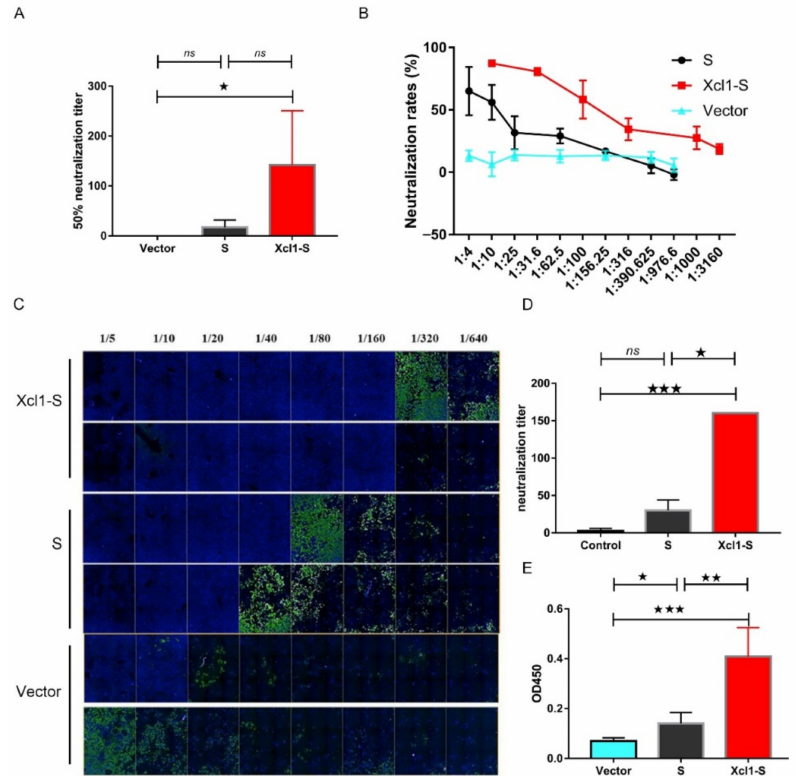
Figure 4. SARS-CoV-2 wild-type and pseudovirus neutralization assay. ( A ) The 50% neutralization titer of serum samples obtained from Xcl1-S-, S- or pVAX1-immunized mice were analyzed using VSV- based pseudovirus displaying spike, which carried an mCherry gene. ( B ) The mCherry fluorescence inhibition rates for different serum dilution ratios were displayed. Curve fitting was used to determine the half-maximal inhibitory concentrations (NT50), which were presented as the neutralization titers in ( A ). ( C ) Fold change in serum neutralization titers against wild-type viruses. ( D ) A statistical analysis was performed for ( C ) using a two-tailed paired t test. ( E ) Detection of SARS-CoV-2 S protein-reactive antibodies in alveolar lavage fluid. C57BL/6 mice ( n = 5 per group) were immunized on days 0 and 14 with Xcl1-S, S or pVAX1. Alveolar lavage fluid was collected with a 1:100 dilution on day 28 and assayed for SARS-CoV-2 spike protein-specific IgG antibodies using an ELISA assay. (cid:70) , p < 0.05, (cid:70)(cid:70) , p < 0.01, (cid:70)(cid:70)(cid:70) , p <